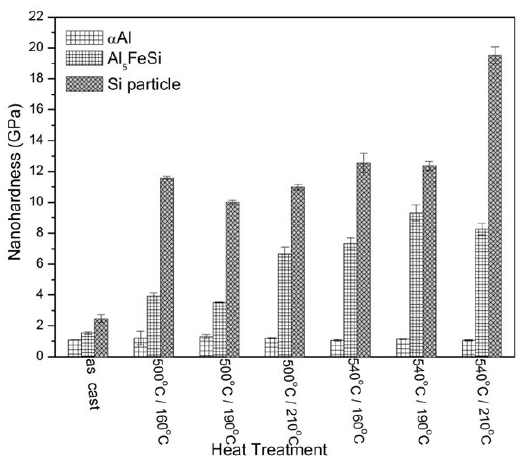
Figure 12. Elastic Modulus behavior for each relevant phase of the Al-Si-Cu alloy obtained from nanoindentation